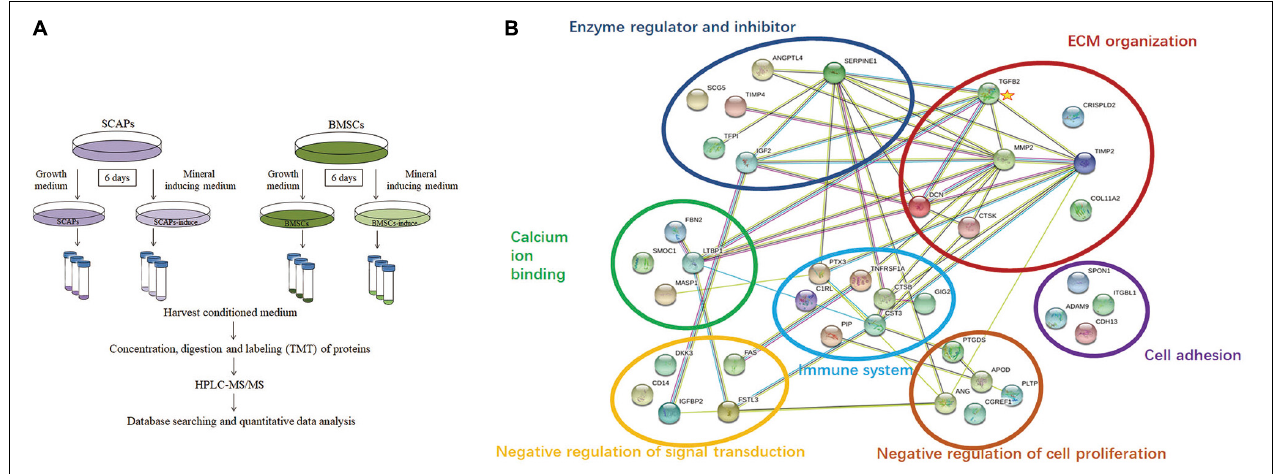
FIGURE 2 | Bioinformatics analysis of the secretome. (A) Procedure workflow. (B) Functional network of upregulated extracellular proteins during odonto/osteogenic differentiation of SCAPs by String software. The proteins belonged to seven major functional classes. The interaction network of differentially expressed genes indicated that matrix metalloproteinase2, serpin family E member 1, metallopeptidase inhibitor 2, decorin, cystatin C, transforming growth factor- β 2 (TGF β 2), and insulin-like growth factor 2 (IGF2) were the most important genes in the network with powerful mediation ability. Among these genes, TGF β 2 was a key node with interaction with six